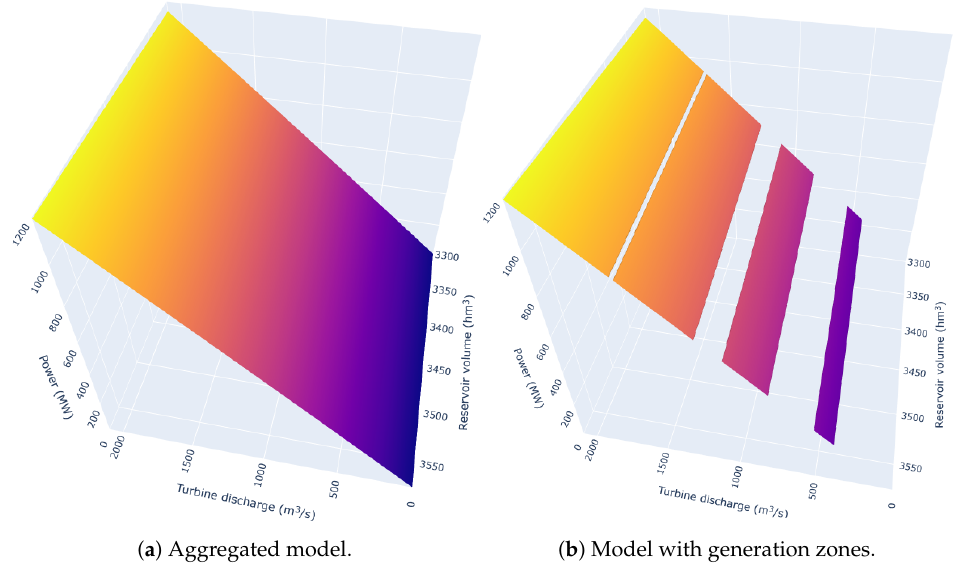
Figure 1. Hydropower generation of Salto Caxias as a function of the total turbine discharge and the reservoir volume. While in the aggregated model represented in ( a ) Salto Caxias has a continuous range of permissible generation points, in ( b ), the permitted generation ranges are separated from each other by forbidden zones.